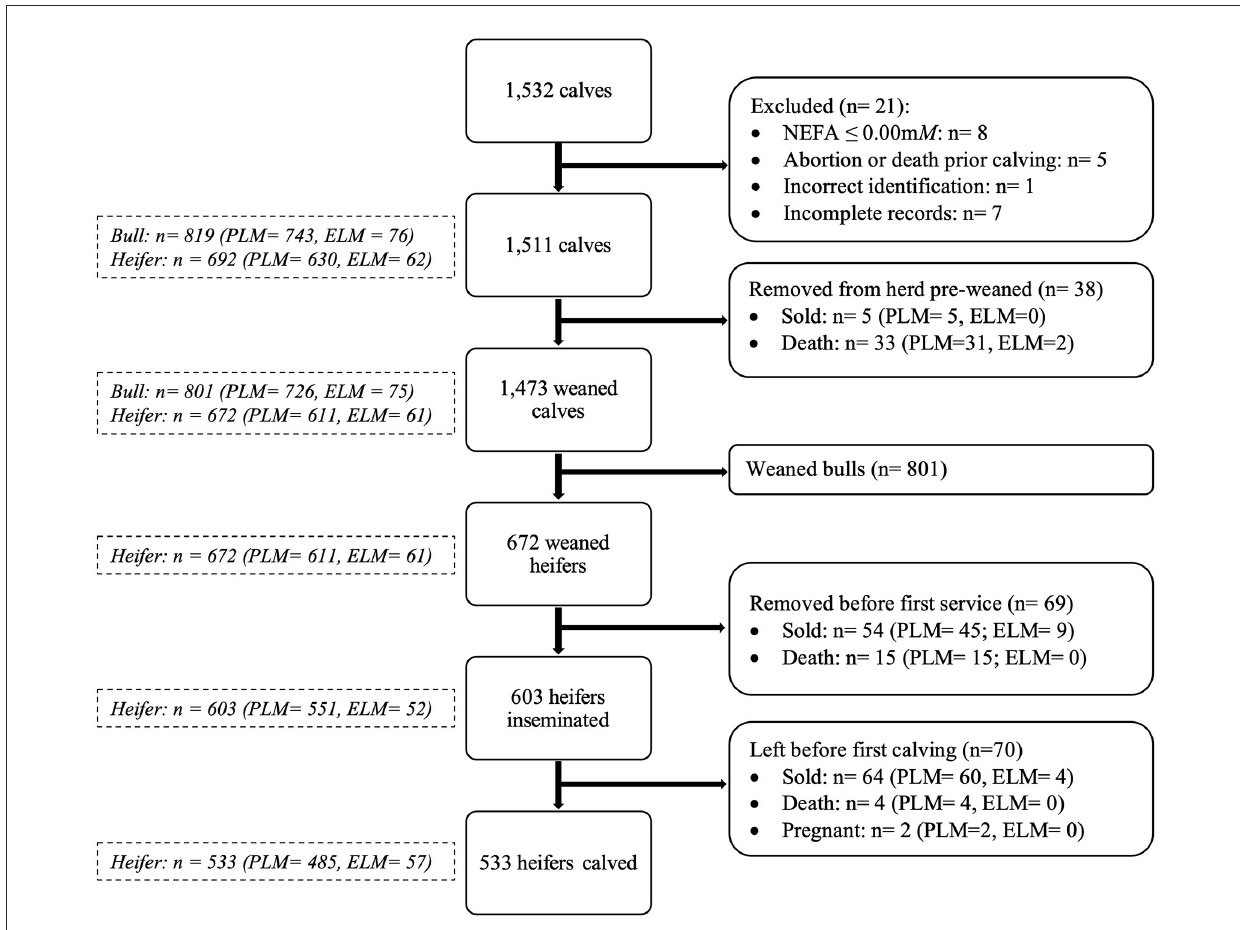
FIGURE1 Flow chart describing the number of animals considered in the study (PLM, physiological lipid mobilization; ELM, excessive lipid mobilization).